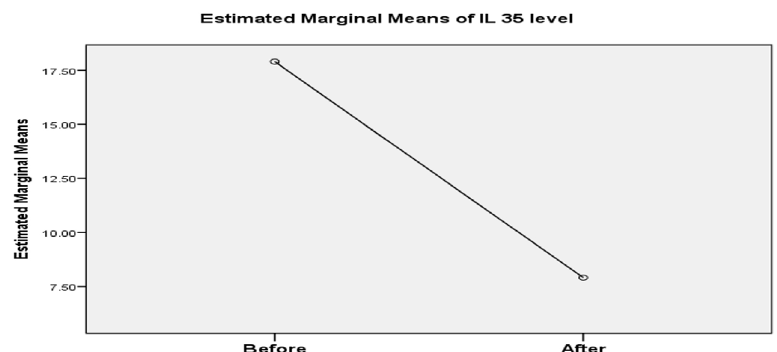
Fig. 3. Comparison between IL-35 levels in serum among patients before treatment and 3 months after treatment end.